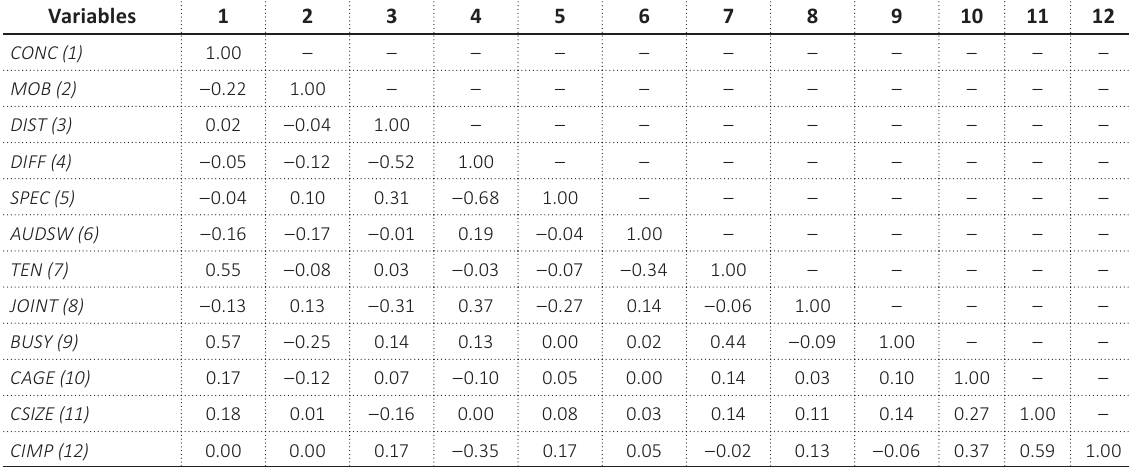
Table 3. Correlation